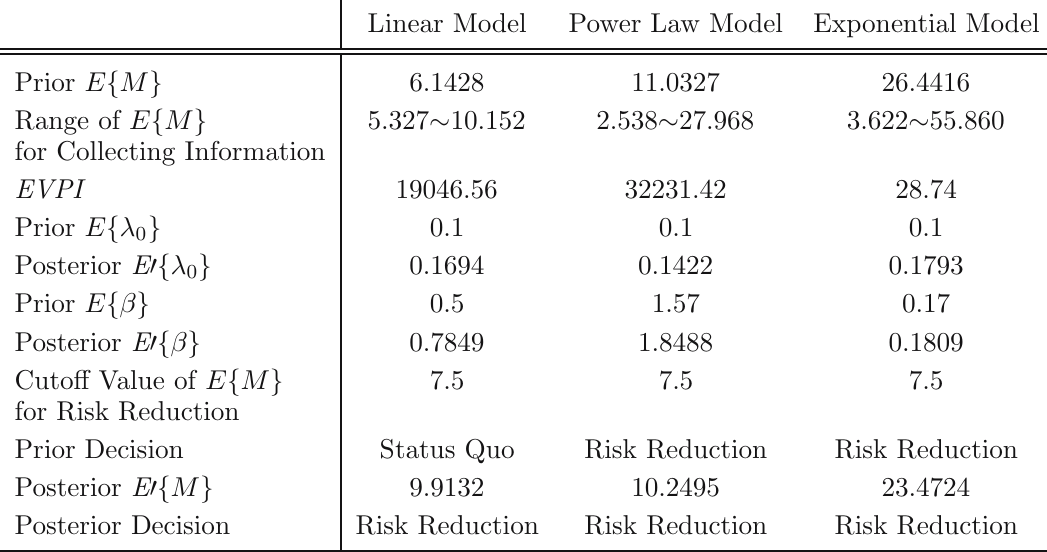
Table 2 Decision Analysis for the Case of